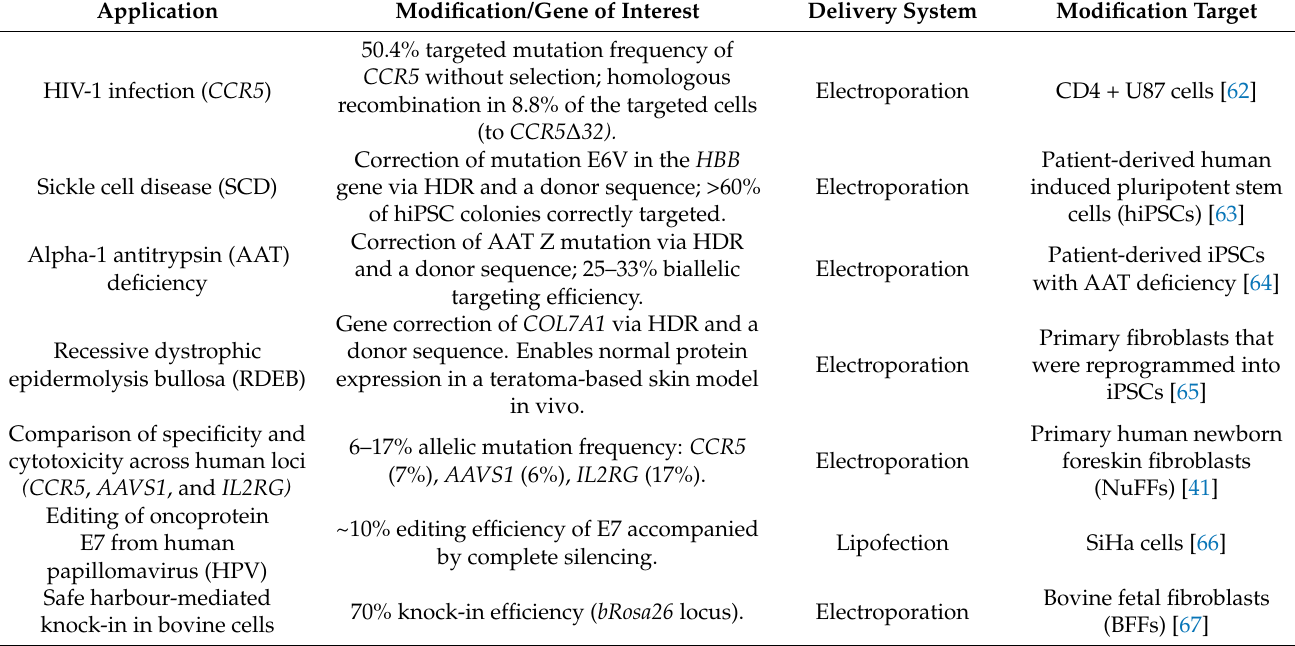
Table 4. Efficiency rates and modifications obtained using